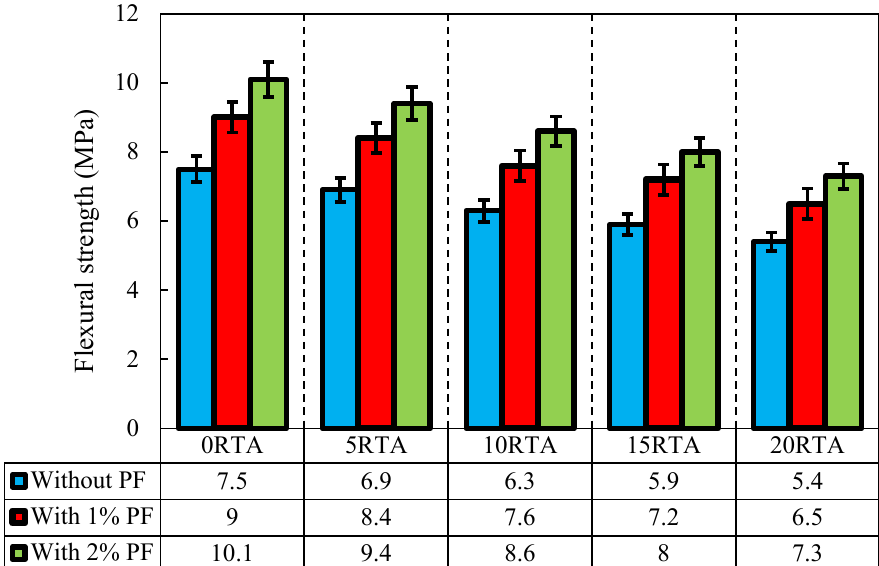
Figure 10. Fracture energy test arrangement.